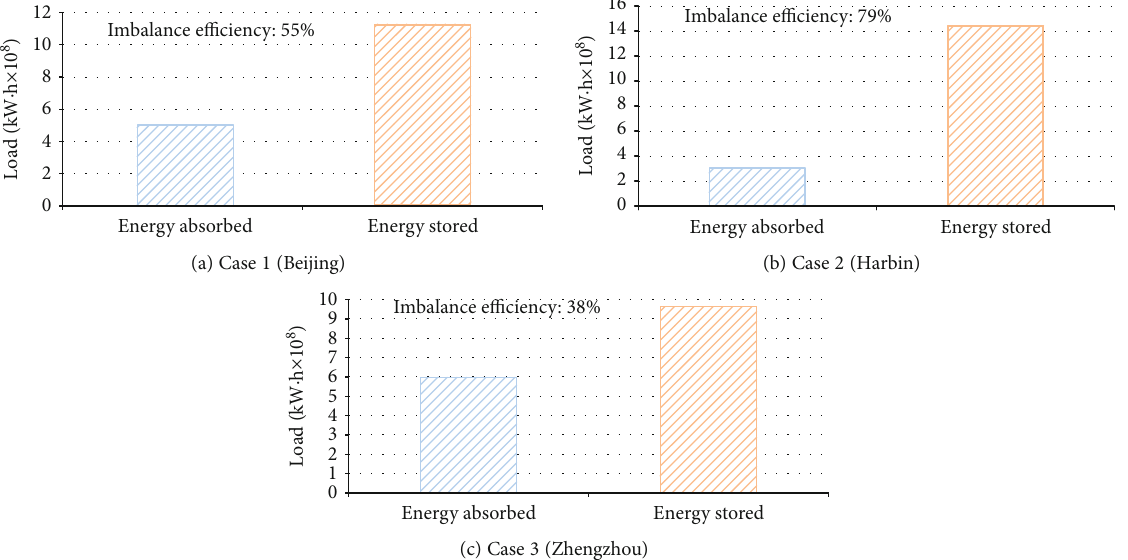
Figure 10: Imbalance e ffi ciency in the Beijing, Harbin, and Zhengzhou